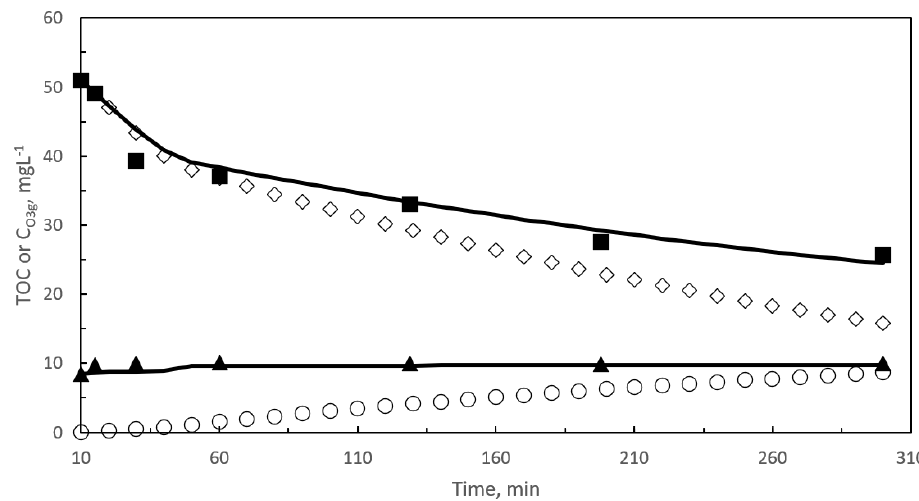
Figure 5. Kinetic model results in ozonation. Second reaction period. Changes with time of calculated and experimental concentrations of TOC (TOC 1 and TOC 2 ) and ozone in the gas leaving the reactor. Black symbols: experimental results: (cid:4) TOC, (cid:78) C O3g . Empty symbols: Calculated TOC 1 , TOC 2 ,. Curves: TOC and C O3g , calculated results: Experimental conditions as in Figure 1. Experimental TOC values taken from [30].